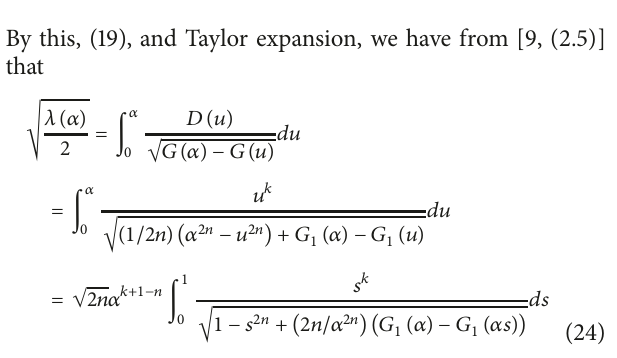
Figure 5: The graph of 𝜆(𝛼) for 𝑘 = 1 , 𝑛 = 3